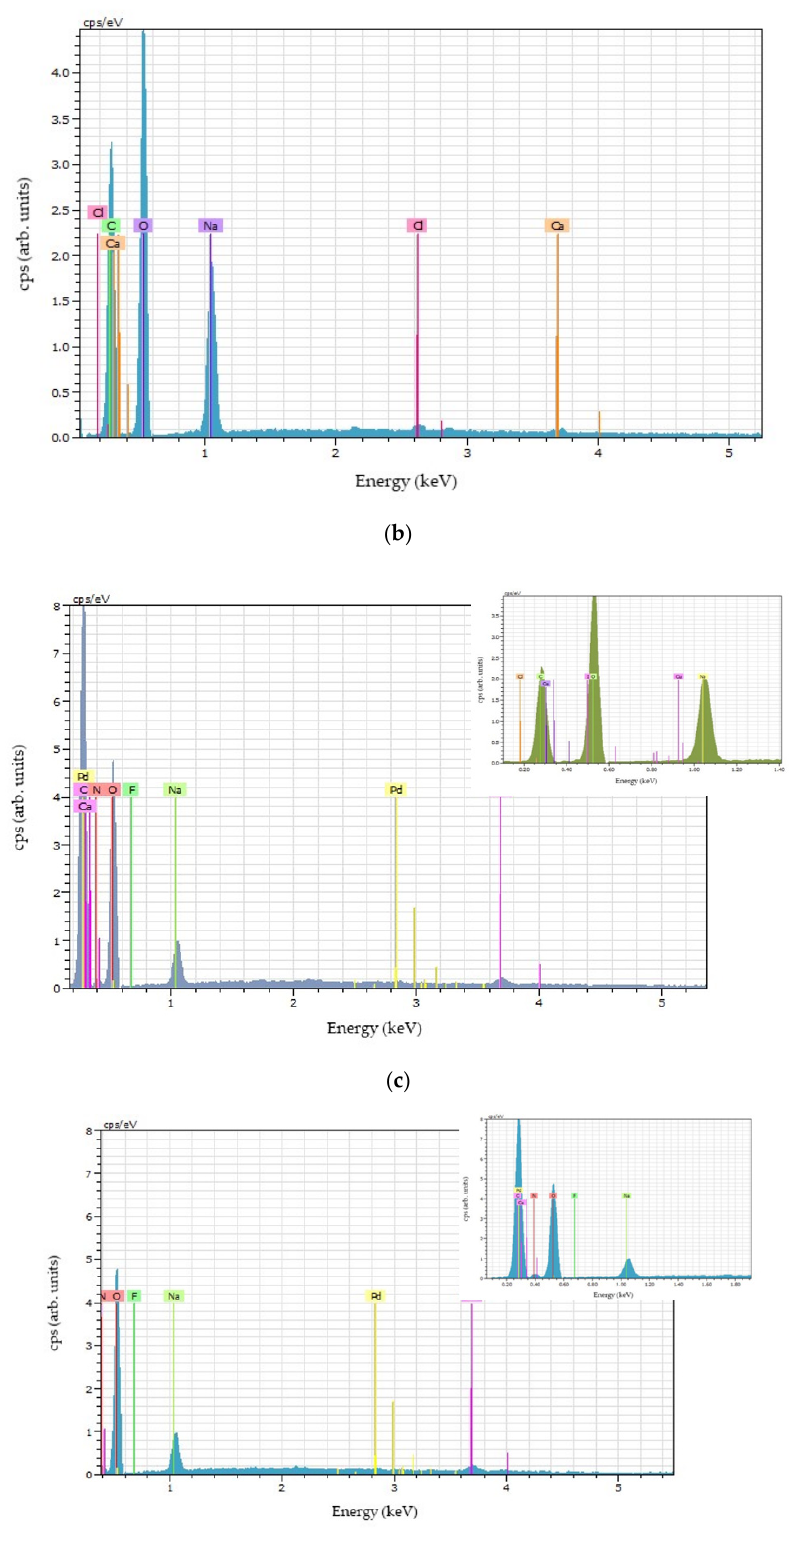
Figure 4. EDX spectra of NaAlg ( a ); AlgOX ( b ); and AlgOX-DA ( c ). In the inset, the spectra is in the range of 0–2 keV.